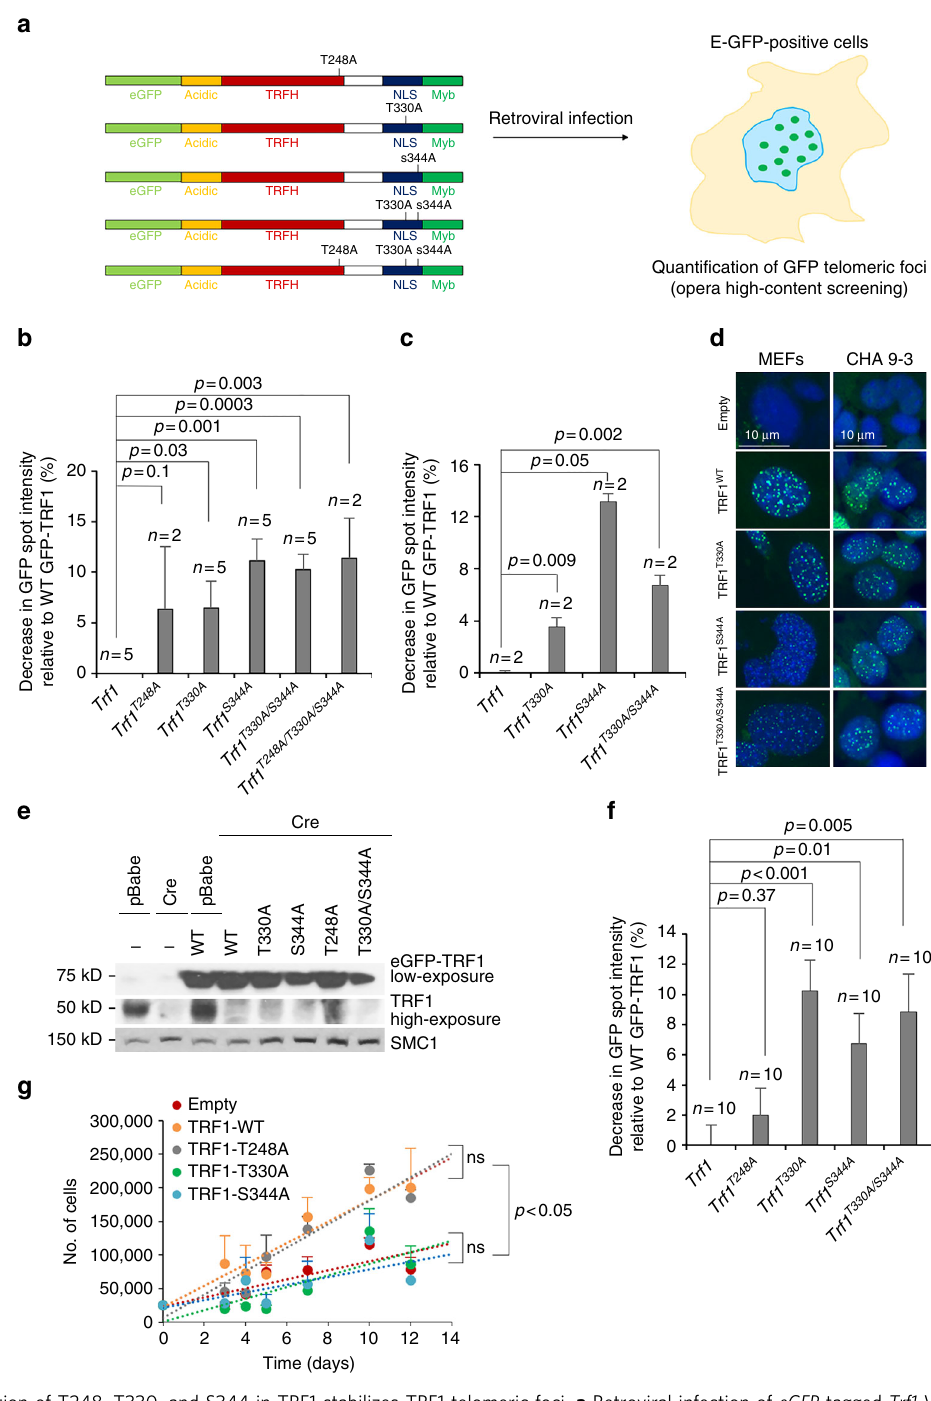
Fig. 6 Phosphorylation of T248, T330, and S344 in TRF1 stabilizes TRF1 telomeric foci. a Retroviral infection of eGFP -tagged Trf1 WT or mutant alleles ( Trf1 T248A , Trf1 T330A , Trf1 S344A , Trf1 T330A/S344A , and Trf1 T248A/T330A/S344A ) was performed to overexpressed depicted TRF1 variants. The mean GFP spot intensity per cell was quanti fi ed by Opera high-content screening (HCS). b , c Quanti fi cation of the decrease in mean GFP-TRF1 spot telomeric intensity in transduced wild-type MEFs ( b ) and in CHA 9-3 cells ( c ). The percent change in mean intensity of TRF1 mutant variants was represented relative to wild- type TRF1. d Representative eGFP-TRF1 immuno fl uorescence images. Scale bars are shown. e Trf1 lox/lox MEFS with or without overexpression of eGFP - Trf1 WT or mutant ( Trf1 T248A , Trf1 T330A , Trf1 S344A , and Trf1 T330A/S344A ) alleles were transduced with the Cre recombinase to delete endogenous Trf1 . As controls, Trf1 lox/lox and Trf1 lox/lox overexpressing WT eGFP-TRF1 were infected with pBabe. Expression of the eGFP-TRF1 variants and of endogenous TRF1 was determined by western blot using a speci fi c TRF1 antibody. f Quanti fi cation of the decrease in mean GFP-TRF1 spot telomeric intensity in transduced Trf1 Δ / Δ deleted MEFs. g Growth rate of Trf1 Δ / Δ deleted MEFs overexpressing eGFP -tagged Trf1 WT and mutant alleles as indicated. Student ’ s t test was used for statistical analysis and P values are shown. Error bars represent standard errors. n number of independent